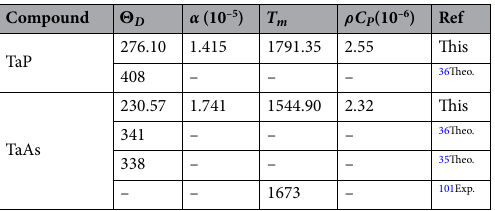
Table 8. The Debye temperature Θ D (K), thermal expansion coefficient α (K −1 ), melting temperature T m (K) and heat capacity per unit volume ρC P (J/m 3 K) of TaP and TaAs compounds.